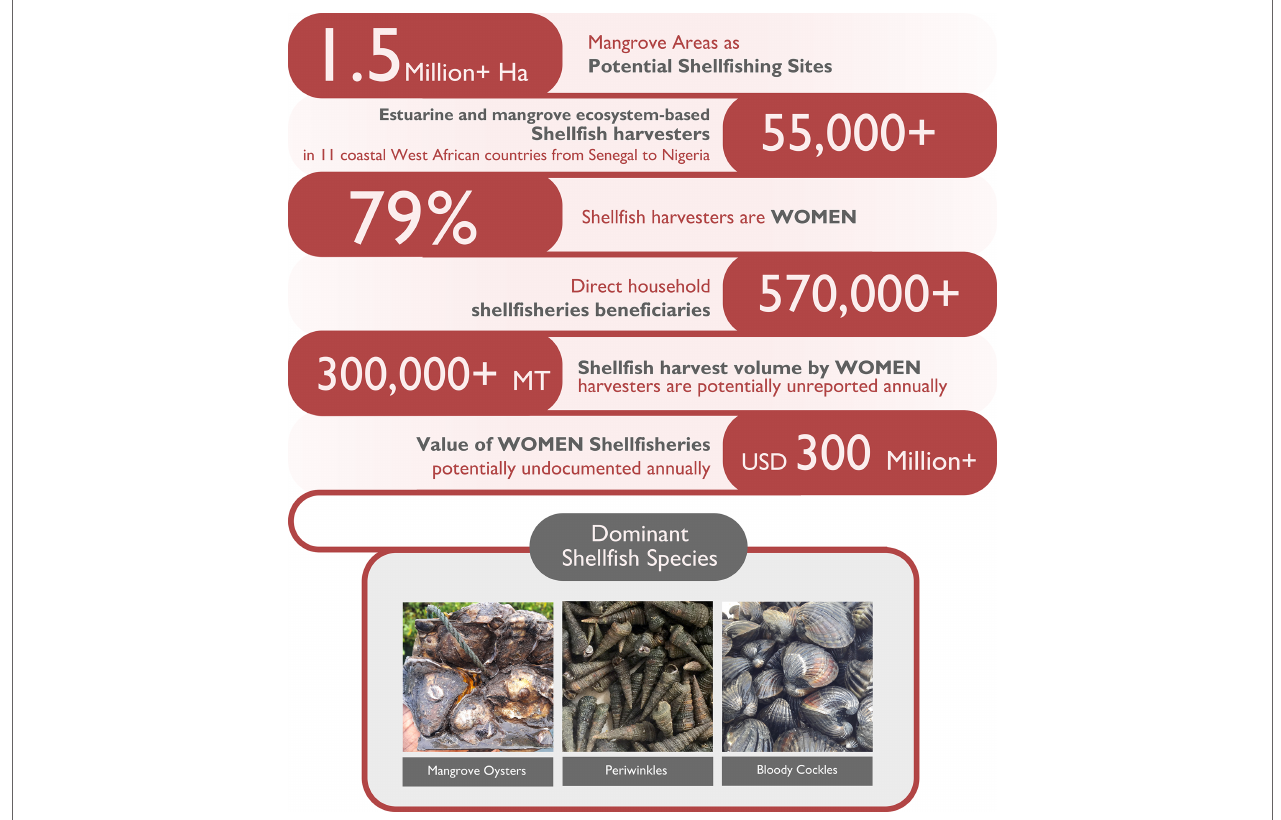
FIGURE 8 | Summary infographic for the estuarine and mangrove ecosystem-based shellfisheries of West Africa. [Infographic developed originally by this study. Data source: Values for the number of shellfishers and their beneficiaries, women’s participation, volume, and value of shellfisheries were obtained from the resource user survey from this study; mangrove area data from Global Mangrove